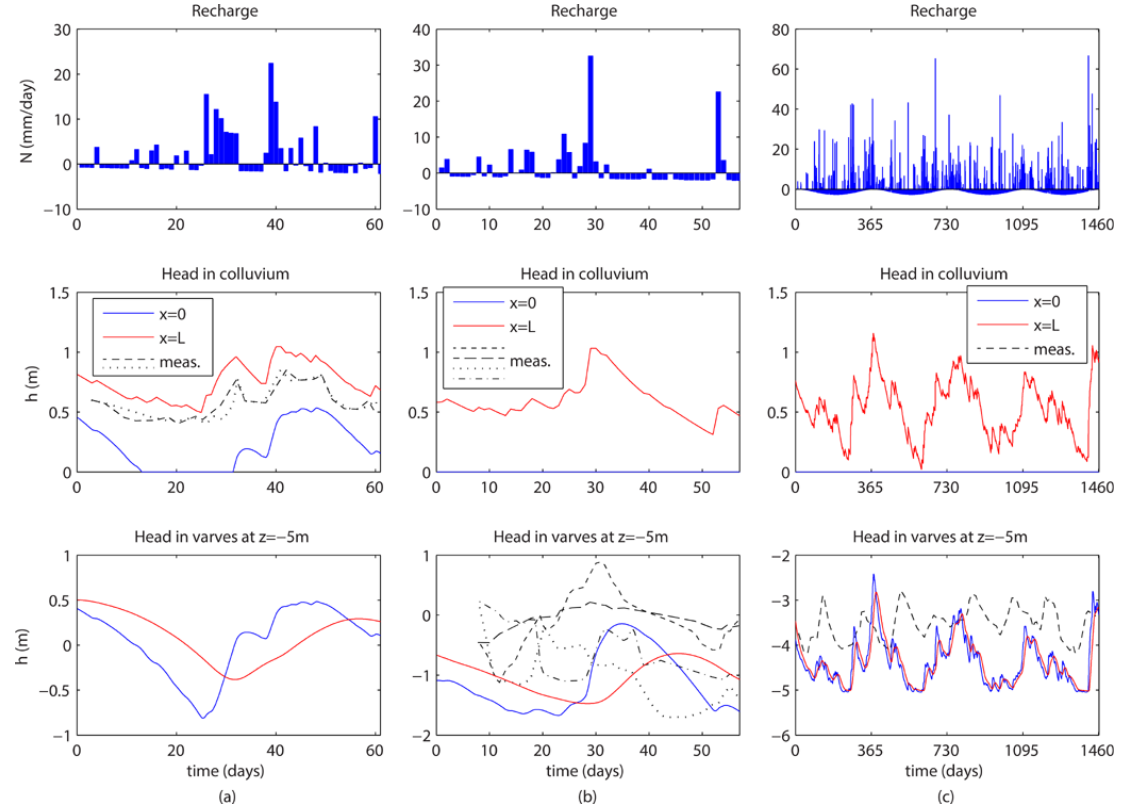
Fig. 7. Recharge (first row), measured and simulated heads for the colluvium (second row) and varved clays (third row) for the La Mure and Monestier du Percy landslides. (a) La Mure, 9 March 1986–8 May 1986, (b) La Mure, 12 March 1987–7 May 1987, (c) Monestier du Percy, 1993–1996. Head variations are shown with respect to the bottom of the colluvium/top of the varved clays. head variations at the bottom of the varved clays are large.